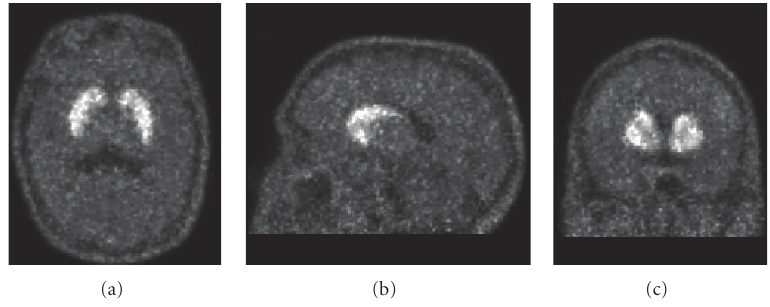
Figure 1: An example of one 11 C-raclopride PET image of a human head: (a) transaxial, (b) sagittal, (c) coronal views.